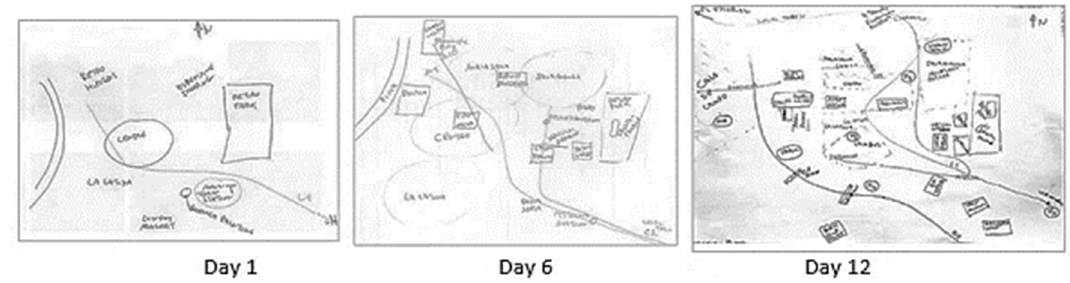
Figure 10. Evolution of sketches of an Explorer tourist throughout the stay (T5 in Figure 4). The number of features is shown to increase, while the coordinated reference system stays the same.